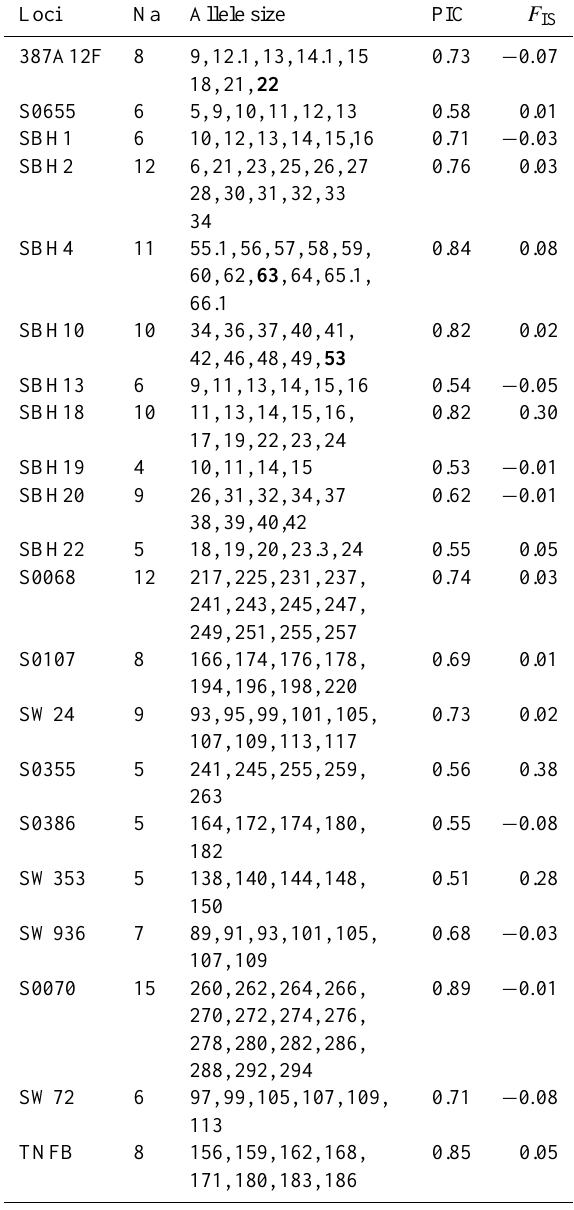
Table 1. Summary statistics for 21 microsatellite loci analysed in Prestice Black Pied pig.